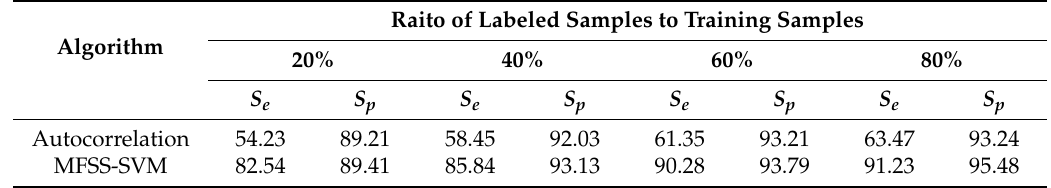
Table 9. Comparison of fall detection between the MFSS-SVM and benchmark algorithm (%).